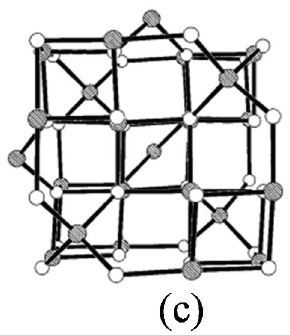
Figure 1. ( a ) Crystal packing of hematite, shaded circles represent Fe and unshaded circles represent O [23]; ( b ) Crystal packing of magnetite, dark large circles represent O, small light circles and small dark circles represent octahedral and tetrahedral coordinated Fe, respectively [24]; and ( c ) Crystal packing of maghemite, shaded circles represent Fe and unshaded circles represent O [23]. Reprinted with permission from reference